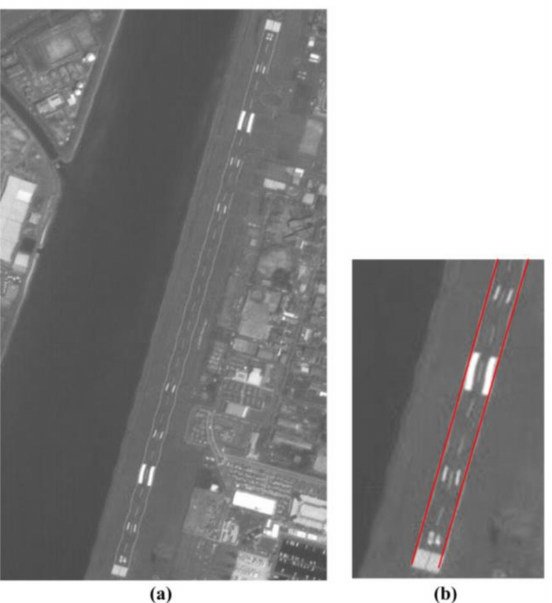
Figure9. Thelinedetectionresultsofatypicalscene.( a )HiroshimaWestAirfieldand( b )enlargeddetails.